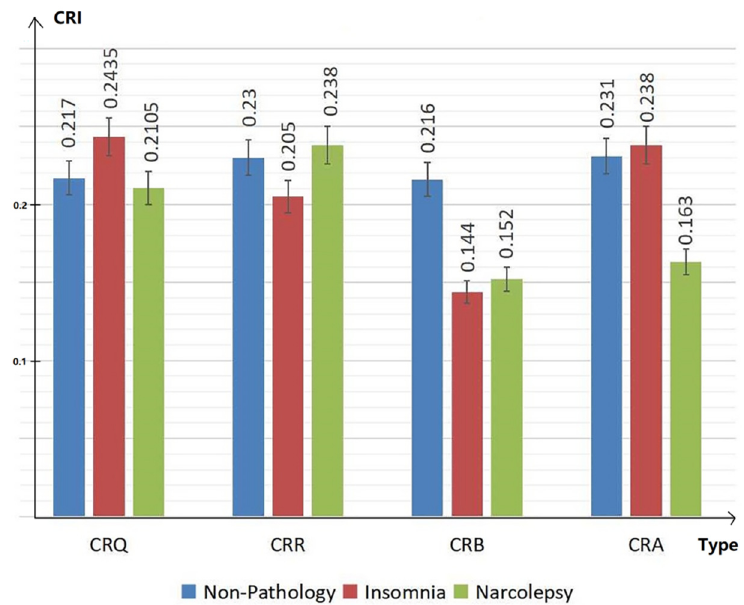
Figure 5. Cardiopulmonary characteristics CRQ, CRR, CRB and CRA during deep sleep of people with non-pathology, insomnia and narcolepsy.